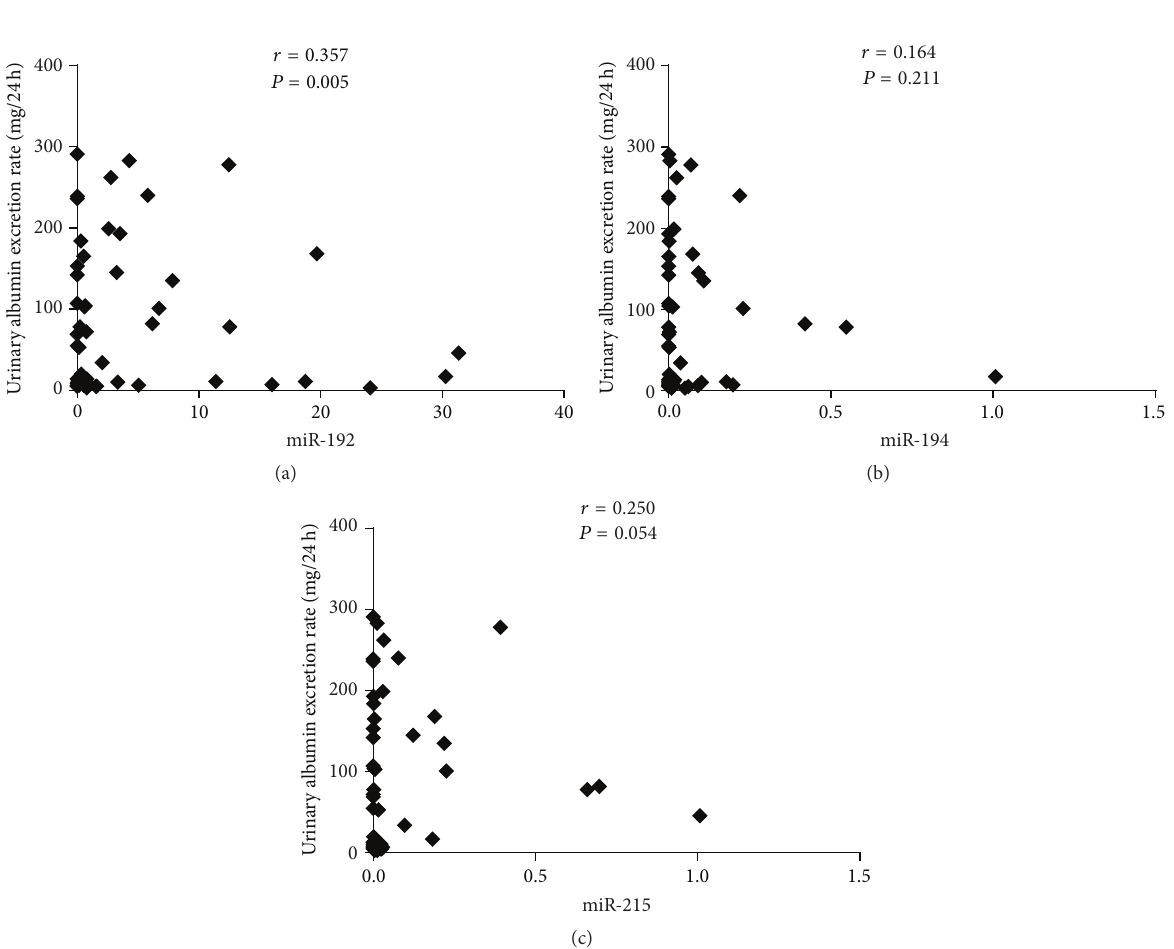
Figure 2: Correlation between urinary EV miRNAs levels and the urinary albumin excretion rate in T2DM patients with normoalbuminuria and microalbuminuria. A significant correlation between miRNA-192 levels and the UAER was detected. miRNA levels were normalized to cel-miR-39 and were calculated using the 2 −Δ CT method. miR-192 expression was significantly correlated with the urinary albumin excretion rate. Data were compared by Spearman’s rank order correlations ( 𝑃 < 0.05 ).